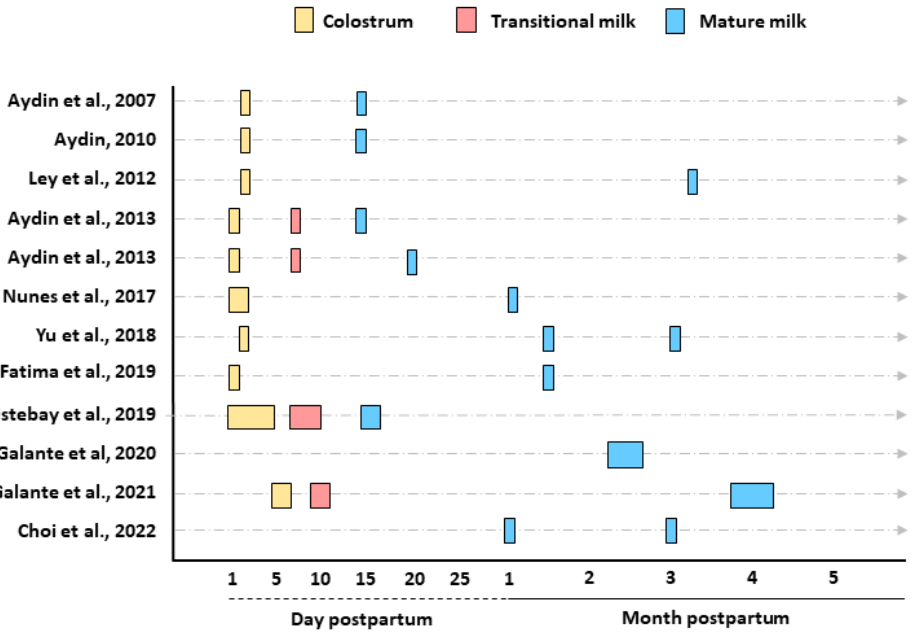
Figure 2. Timing of human milk sample